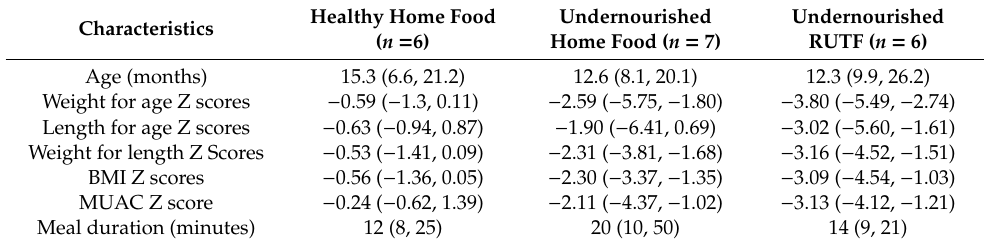
Table 2. Characteristics of children observed in different phases of the study. Data presented as median [range].